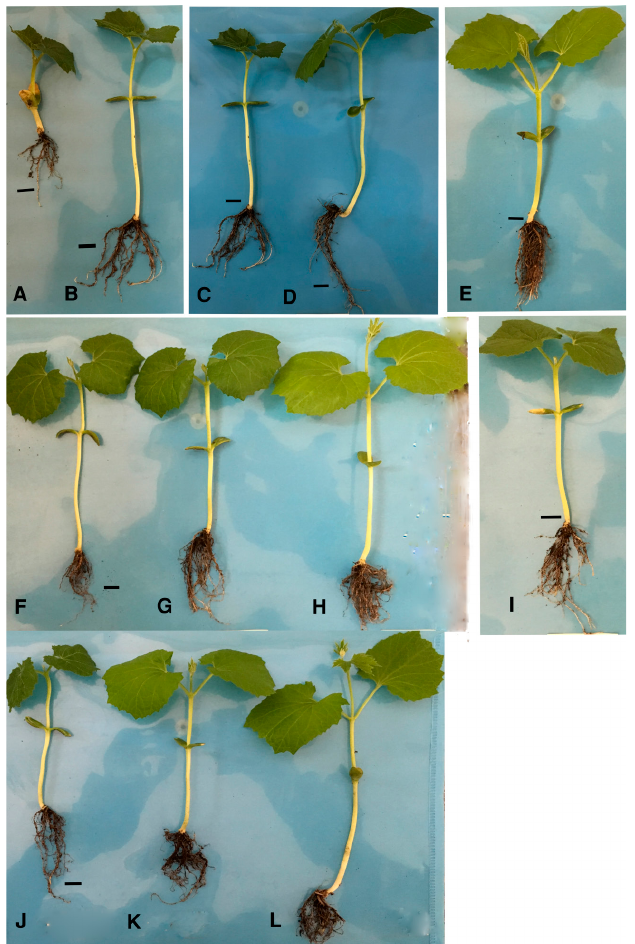
Fig. 3: The recorded differences in plant early growth following seed prim- ing with the plasma and the supplementation of carbon nanotubes (CNT), 8 days after the treatments. A-Control; B-CNT of 50 mgl -1 ; C-CNT of 100 mg l -1 ; D-CNT of 200 mg l -1 ; E-plasma of 60 s; F- plasma of 60 s and CNT of 50 mg l -1 ; G-plasma of 60 s and CNT of 100 mg l -1 ; H-plasma of 60 s and CNT of 200 mg l -1 ; I-plasma of 120 s; J-plasma of 120 s and CNT of 50 mg l -1 ; K-plasma of 120 s and CNT of 100 mg l -1 ; L-plasma of 120 s and CNT of 200 mg l -1